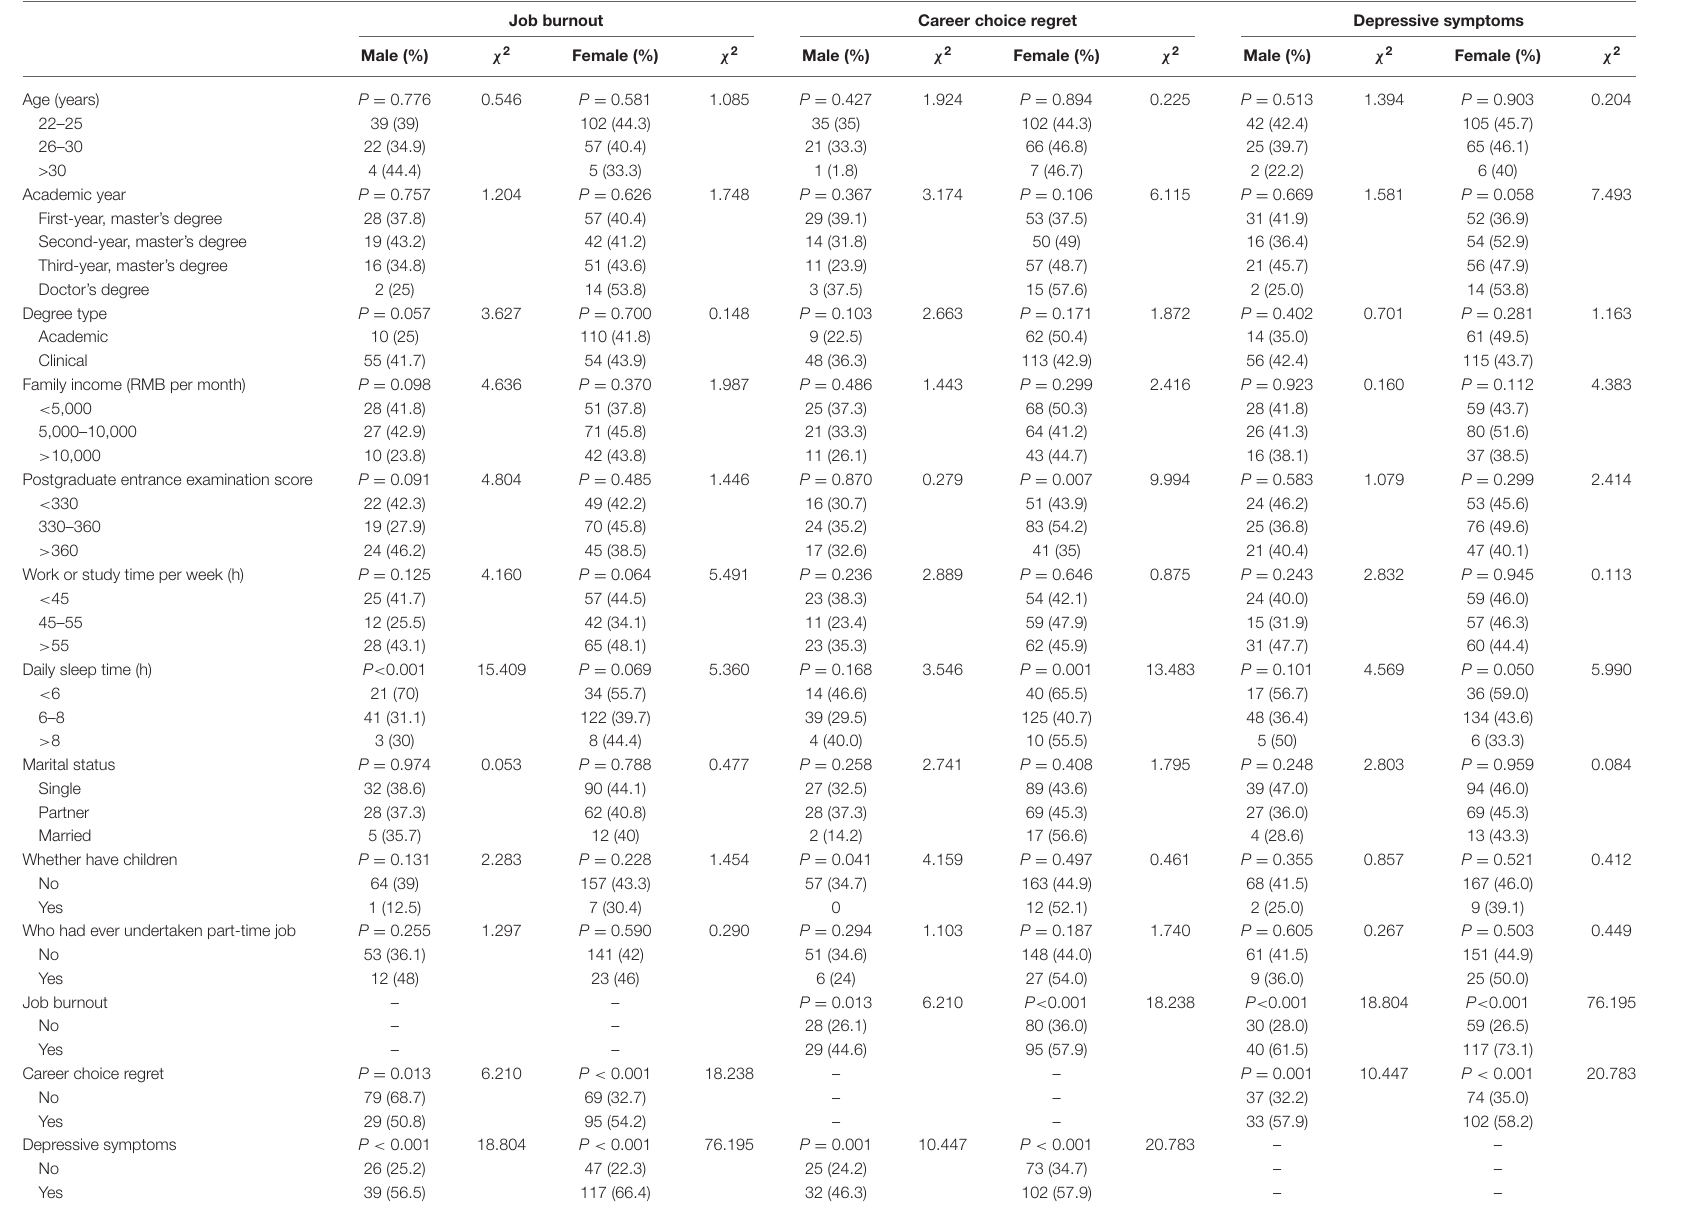
TABLE 3 | Univariate analysis of job burnout, career choice regret, and depressive